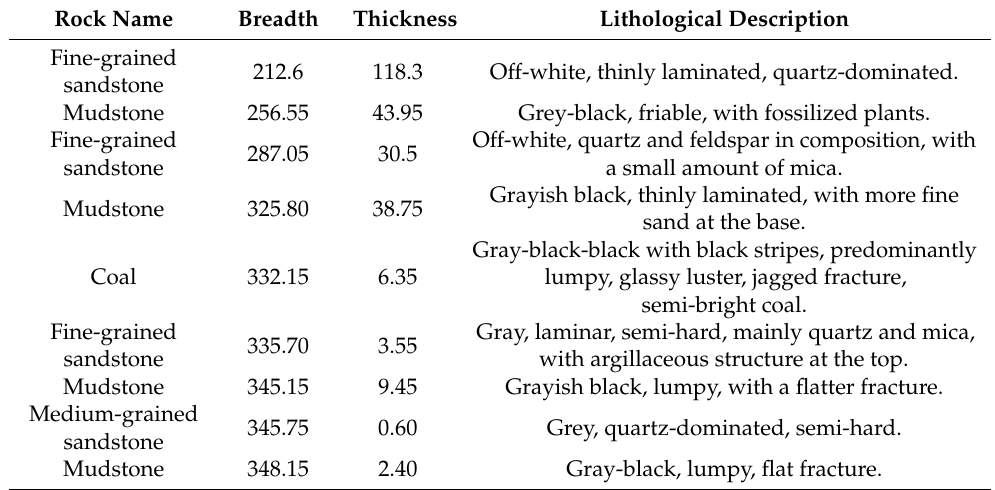
Figure 1. Schematic diagram of the location of the mining area. Table 1. Patch 12 borehole column.